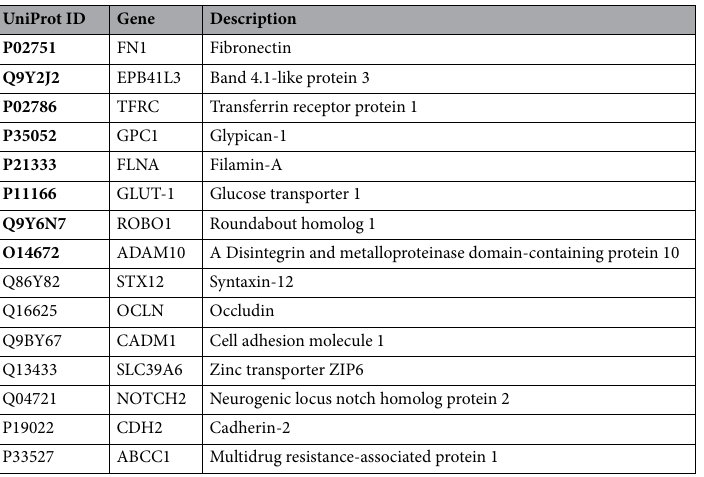
Table 1. List of the membrane proteins suggested as potential breast cancer biomarkers. Bolded UniProt IDs are proteins considered for validation due to their relative high